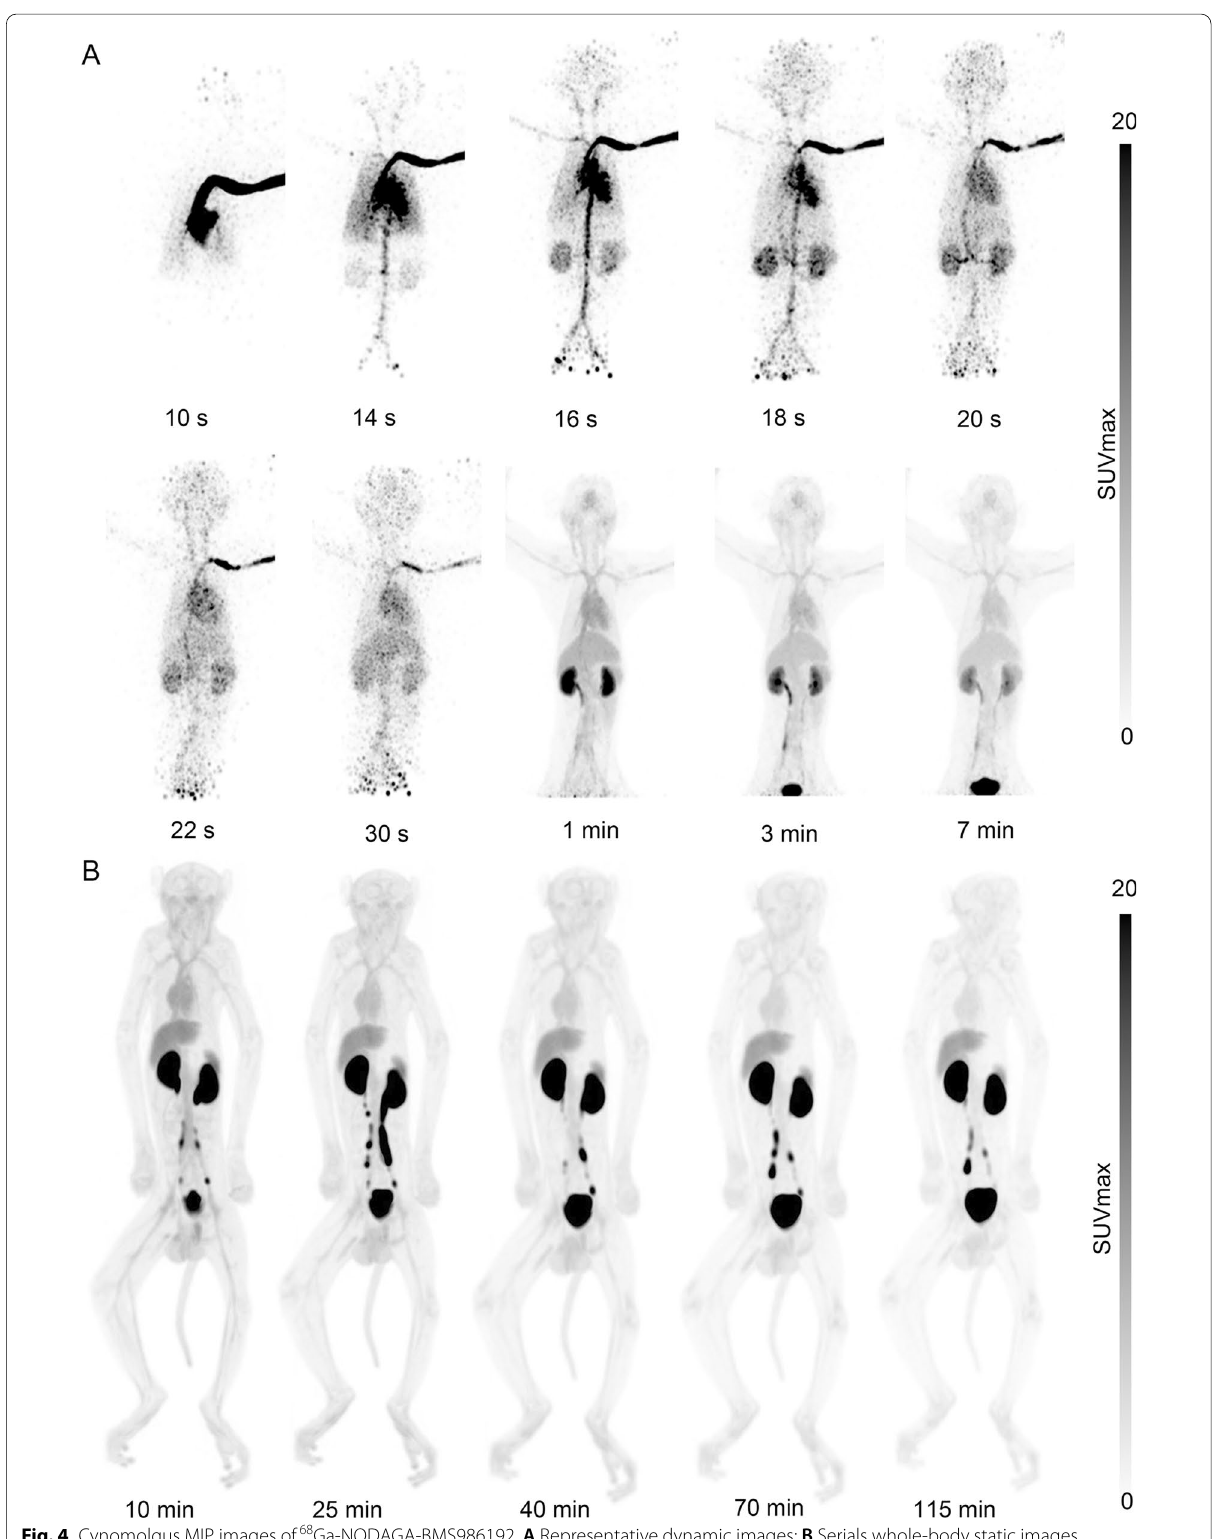
Fig. 4 Cynomolgus MIP images of. 68 Ga-NODAGA-BMS986192. A Representative dynamic images; B Serials whole-body static